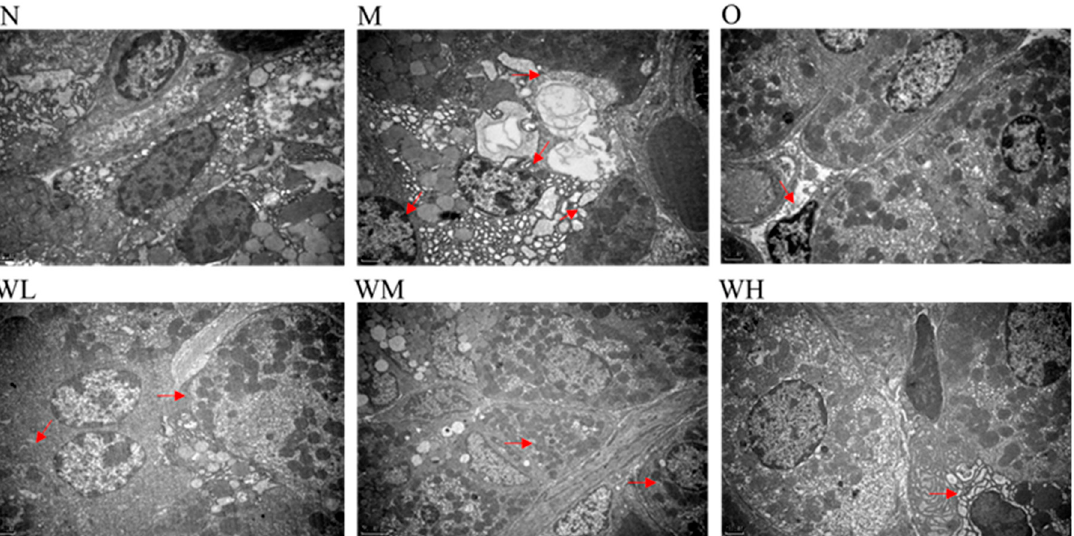
Figure 2. Transmission electron micrograph images of gastric injuries (three per group). The red arrows represent major changes in the organelles. N, normal group; M, model control group; O, omeprazole group (0.02 g/kg); WL, WOPs 0.22 g/kg; WM, WOPs 0.44 g/kg; WH, WOPs 0.88 g/kg. WOPs, walnut oligopeptides.